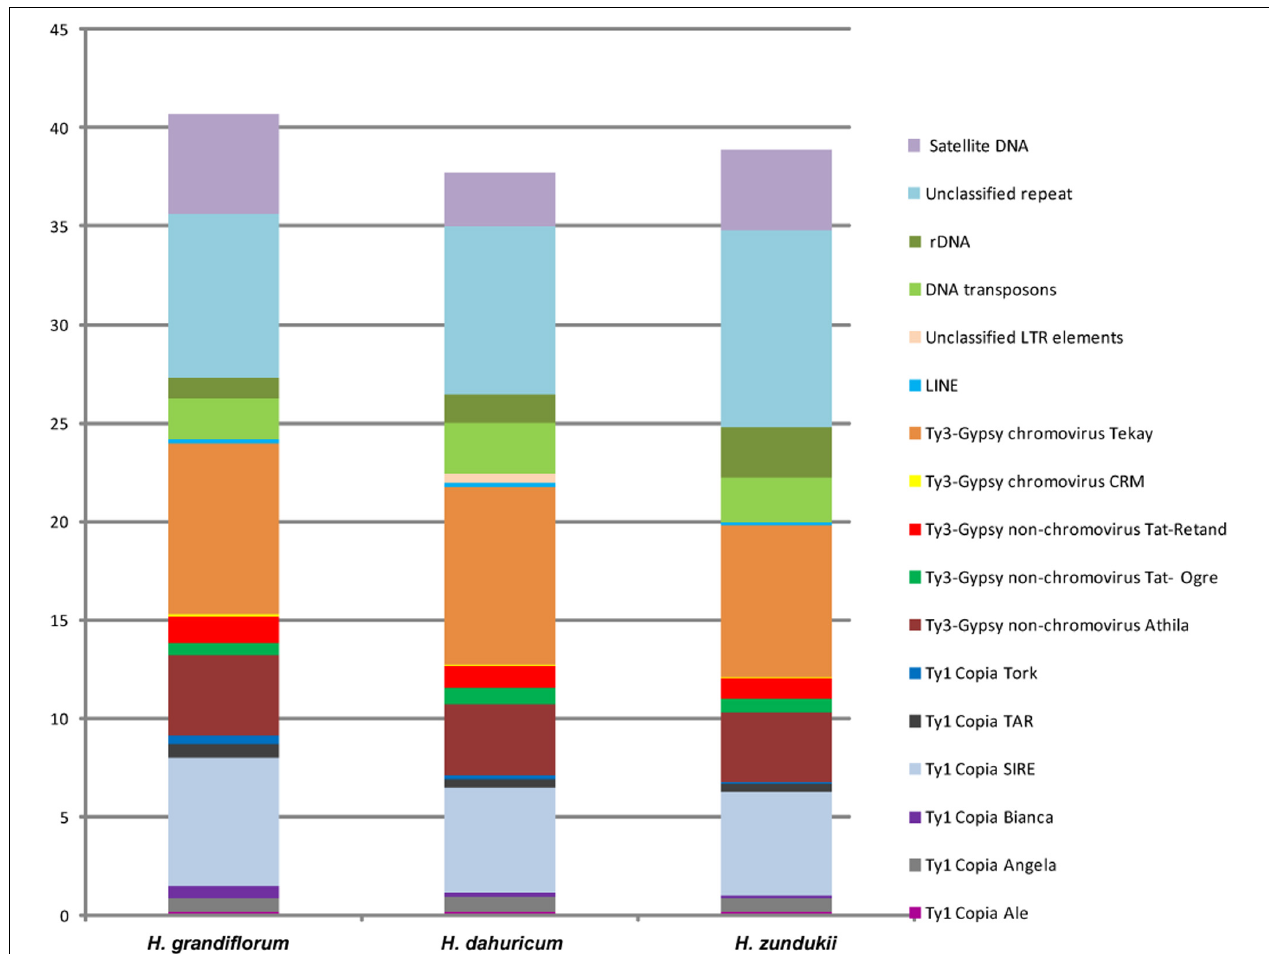
FIGURE 3 | Genome proportion of most abundant DNA repeats in H. grandiflorum , H. dahuricum , and H. zundukii . The genome proportion of individual repeat types was obtained as a ratio of reads specific to individual repeat types to all reads used for clustering analyses by the RepeatExplorer pipelines.